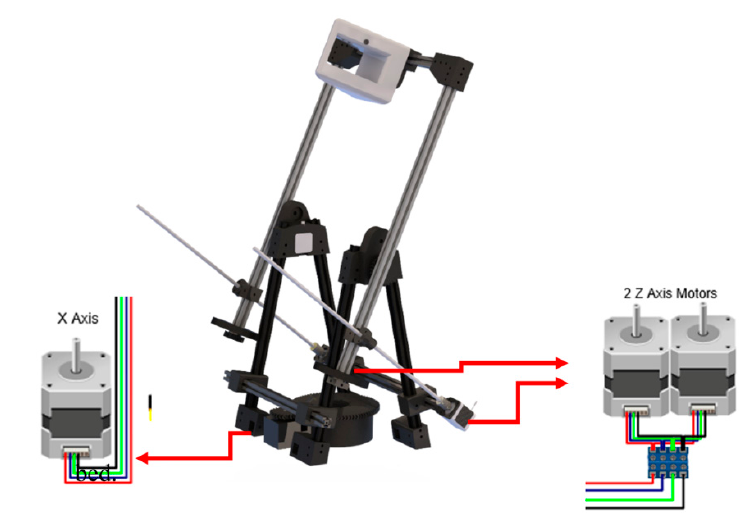
Figure 5. Motors Location. (Source: self-made).